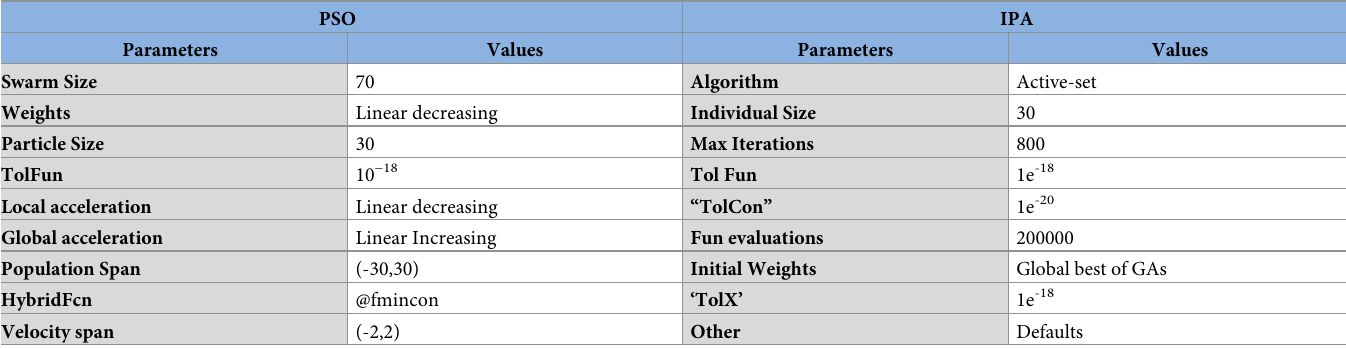
Table 1. Settings of the parameters using PSO and